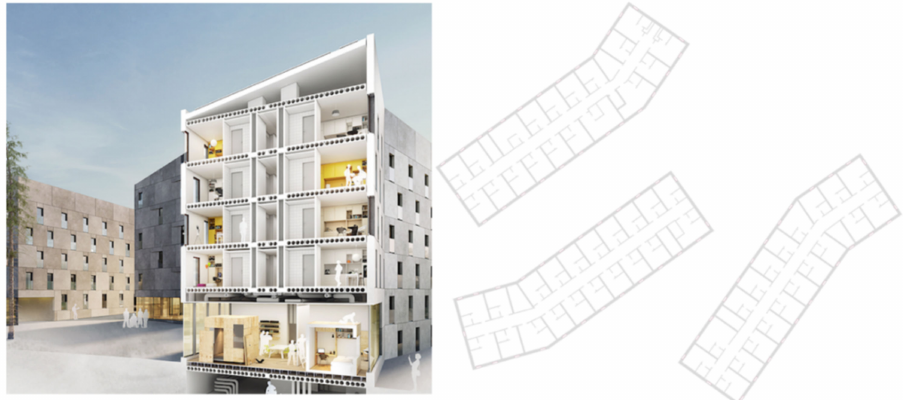
Figure 1. 3D view and typical floor configuration of Testbed EM.